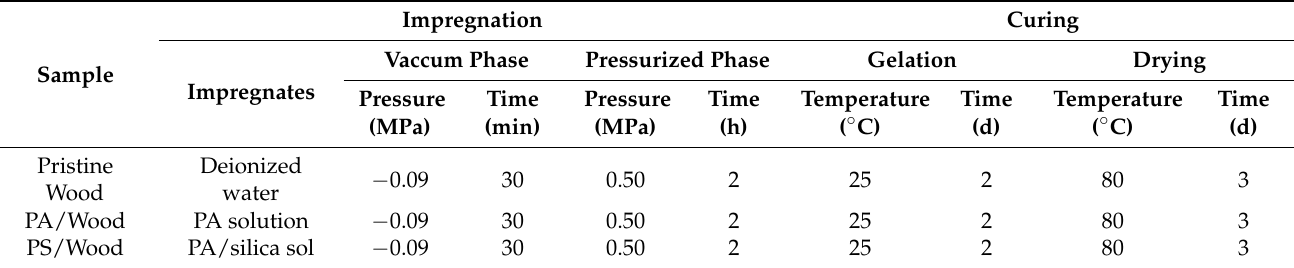
Table 1. Impregnations and curing treatments (gelation and drying) for different experimental